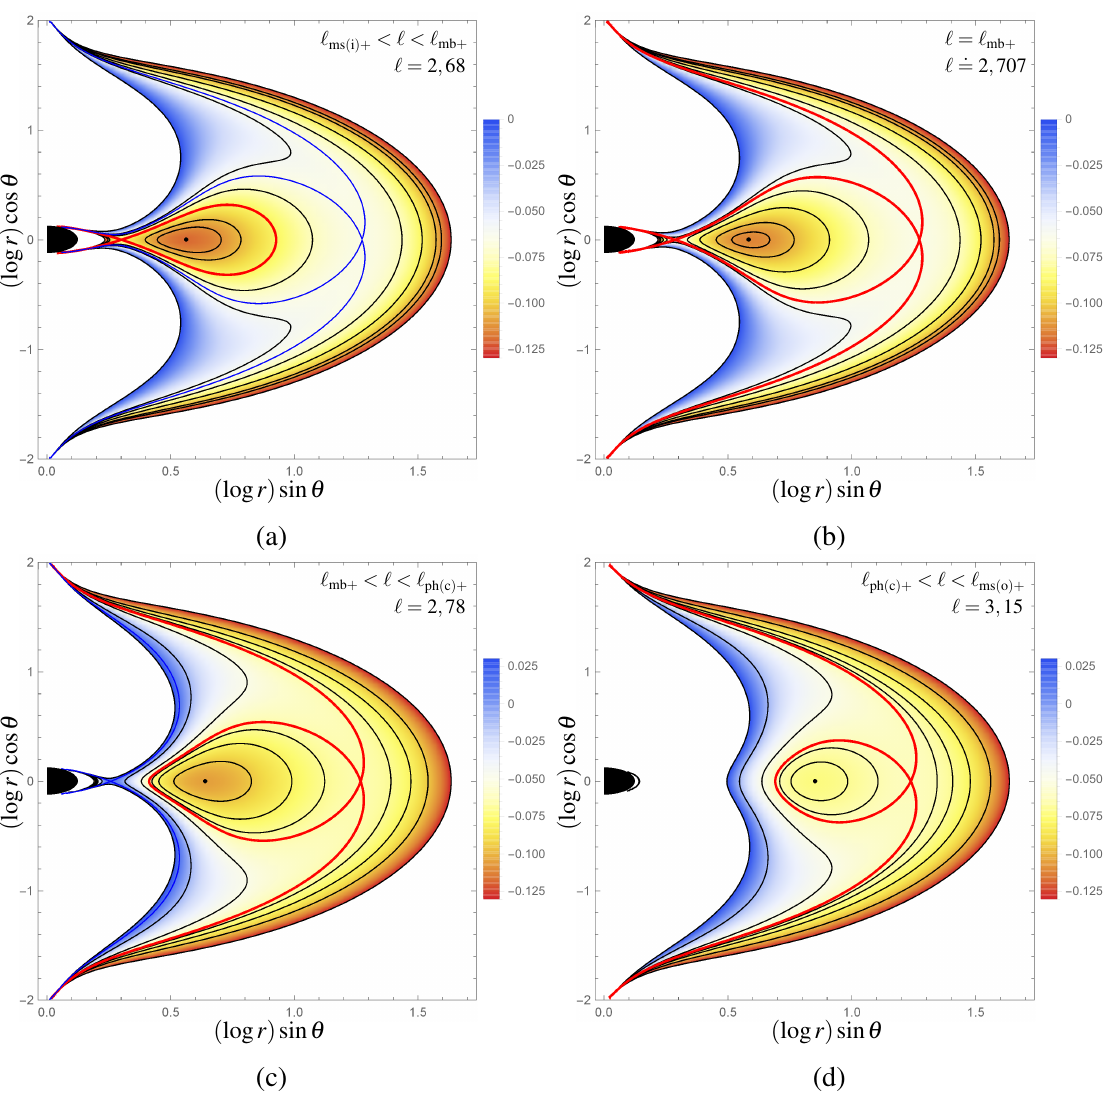
Figure 7. Equipotential surfaces (meridional sections) of the potential W ( r , θ ) in barotropic fluid orbiting a Kerr–de Sitter black hole. We show corotating fluid with uniform distribution of the specific angular momentum (cid:96) ( r , θ ) = const. Depending on (cid:96) , the character of critical equipotential self-crossing toroidal surfaces (red curve) is changed. The blue curve corresponds to the second critical equipotential (if it exists), which is opened. Regions of the potential values corresponding to the colored scales are only shown. Sub-figure (a) corresponds to accretion torus, sub-figure (b) to torus which is simultaneously accretion and excretion, sub-figures (c-d) correspond to excretion